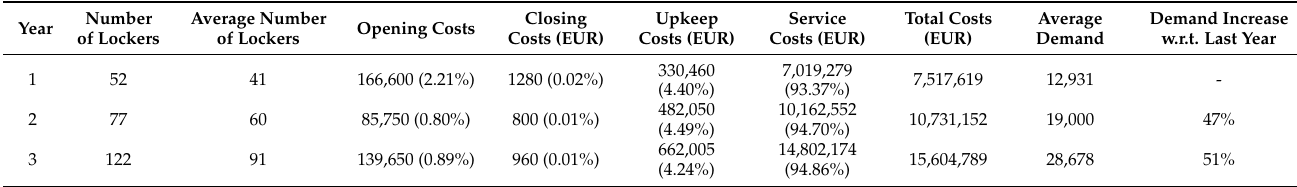
Table 7. Overall analysis for each